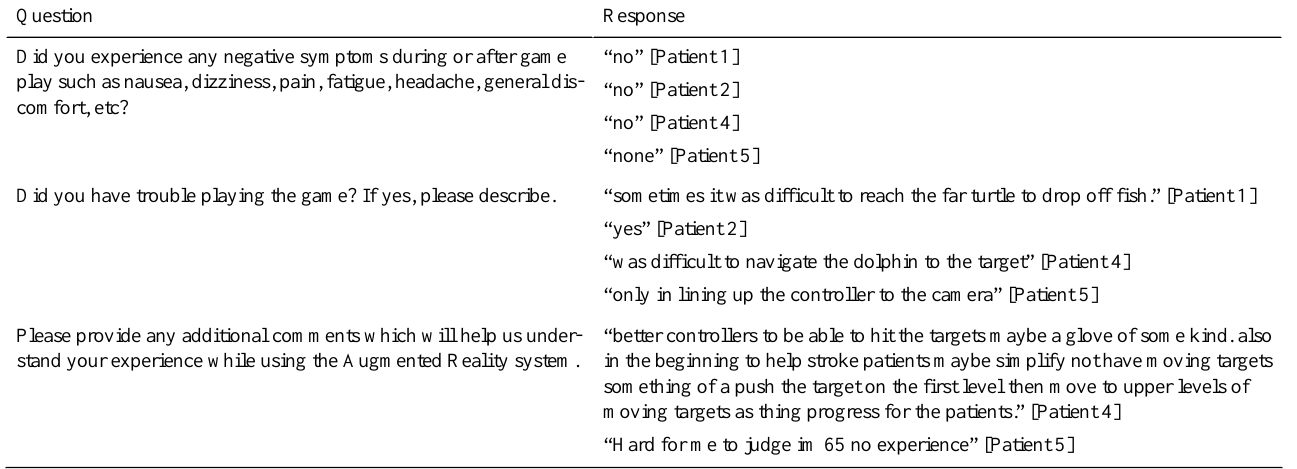
Table 4. Patient